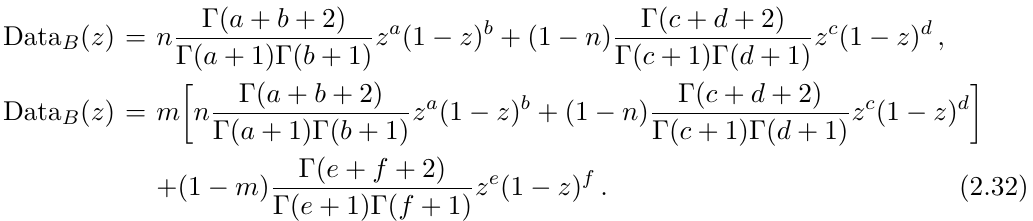
this variable. This uncertainty is taken to be the root mean square (r.m.s.) 1 σ